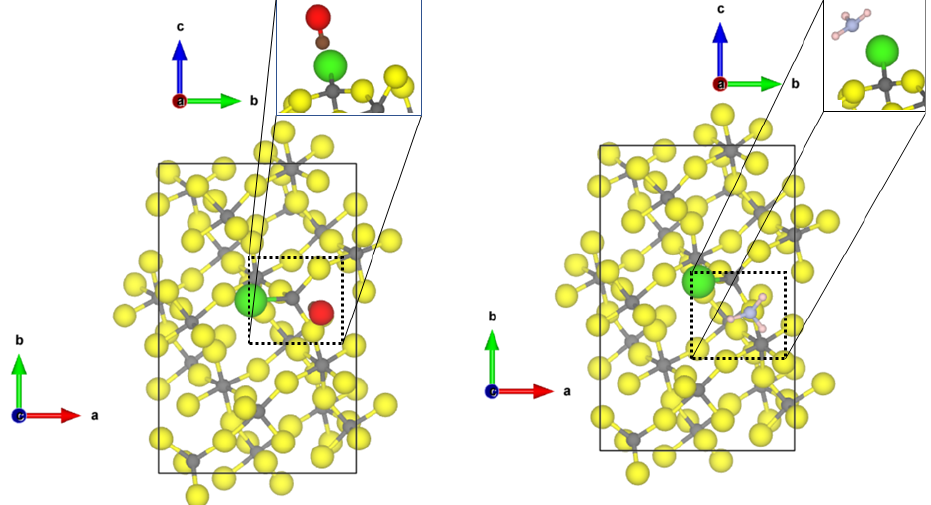
Figure 3. PBE-D3(BJ) optimized structures of the probe molecules CO ( left ) and NH 3 ( right ) on the 1 × 1 Cl-doped α -AlF 3 -(11¯22) surface; yellow = fluorine, grey = aluminium, brown = carbon, red = oxygen, blue = nitrogen, pink =